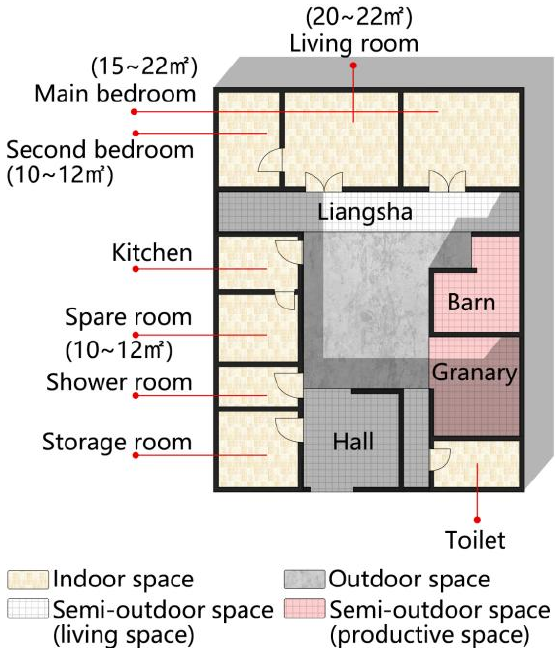
Figure 6. Typical layout of vernacular dwellings in Linyi.